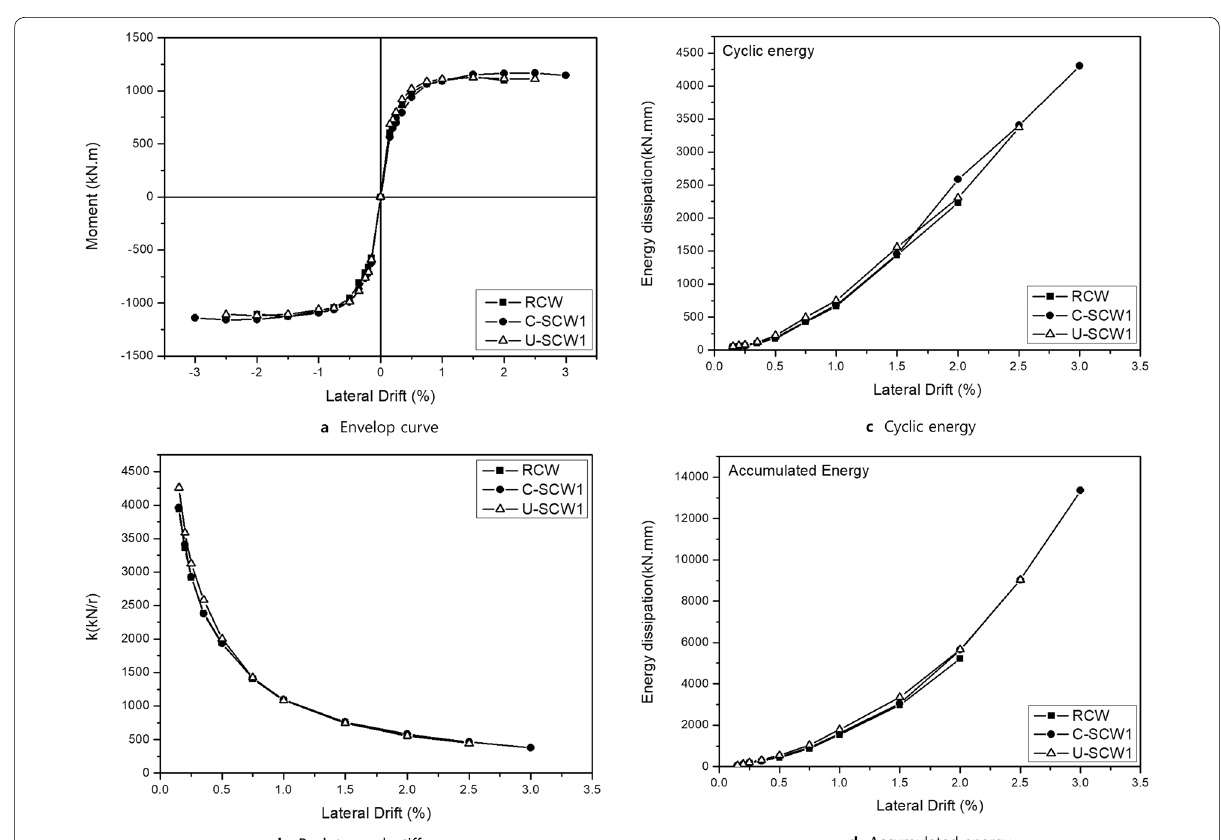
Fig. 13 Comparisons of structural performances for specimens ( P u